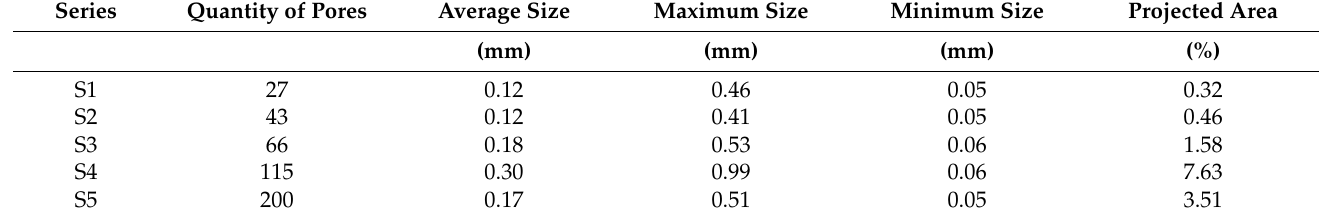
Table 6. Porosity features of welded series.